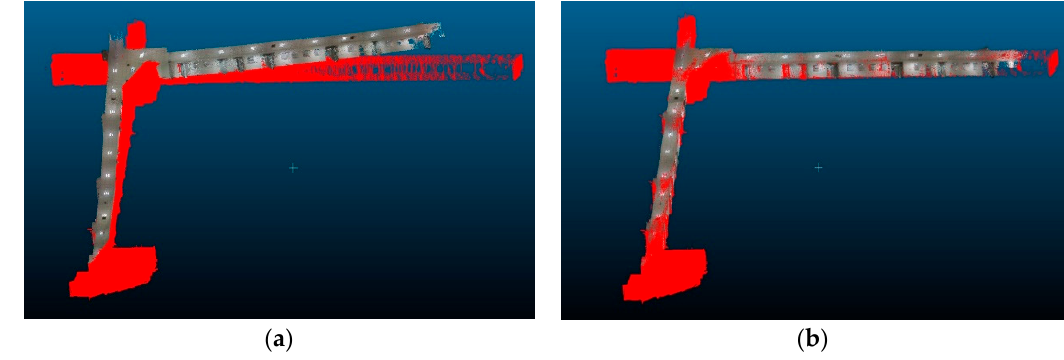
Figure 12. Comparison of models constructed by two methods, with LiDAR data rendered in red. ( a ) Model constructed by ORB-SLAM2 and ( b ) model constructed by the proposed method.